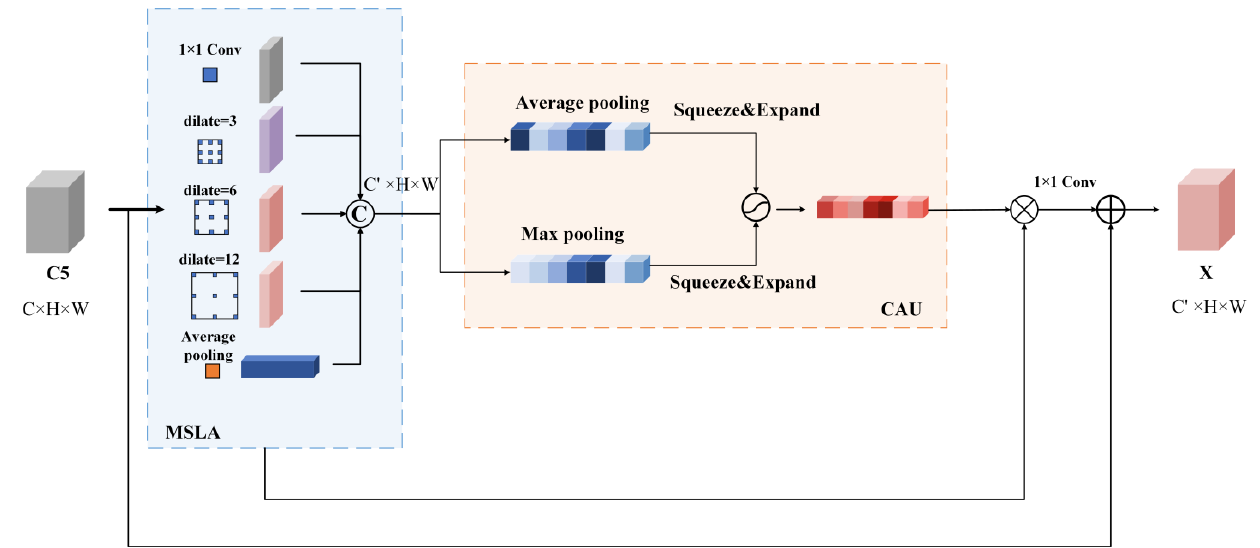
Figure 3. The architecture of EFM. The EFM contains of two parts: a multi-scale local attention module and a channel-guided attention unit.